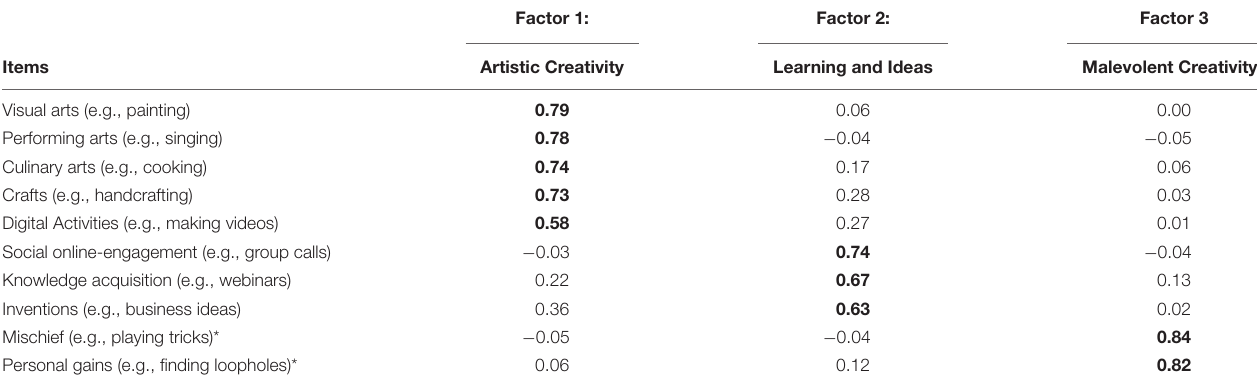
TABLE 3.1 | EFA results of the pooled sample of change in creativity before and during lockdown based on a split sample.